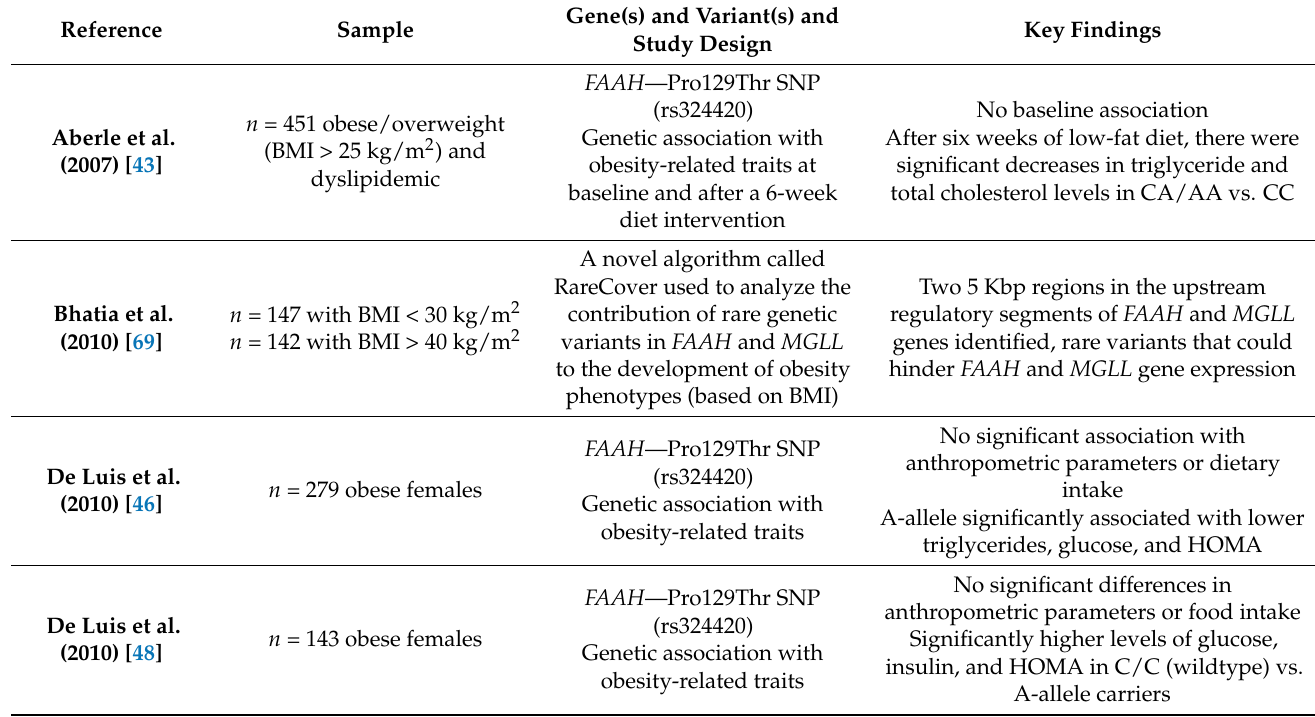
Table 3. Human studies examining genetic association between FAAH and/or MGLL and obesity-related outcomes. Reference Sample Key